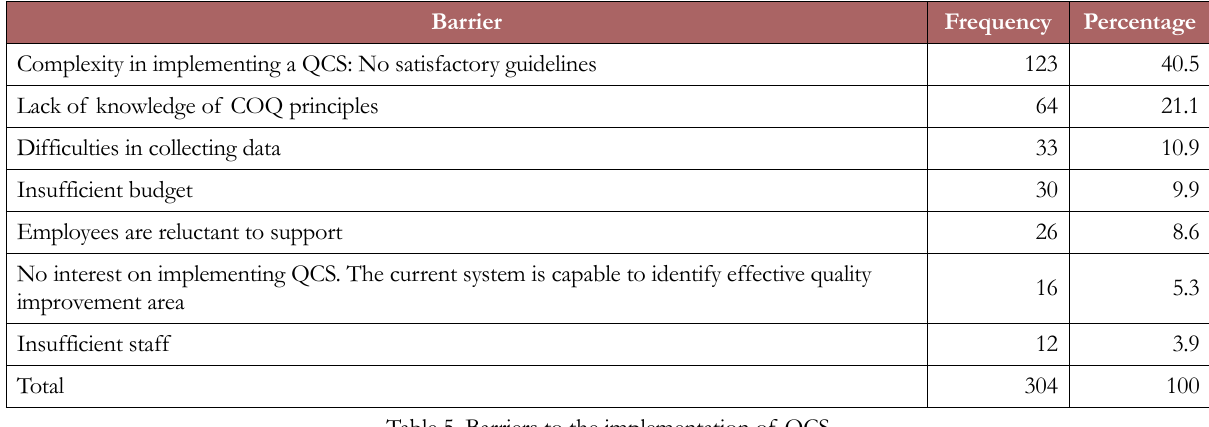
Table 5. Barriers to the implementation of